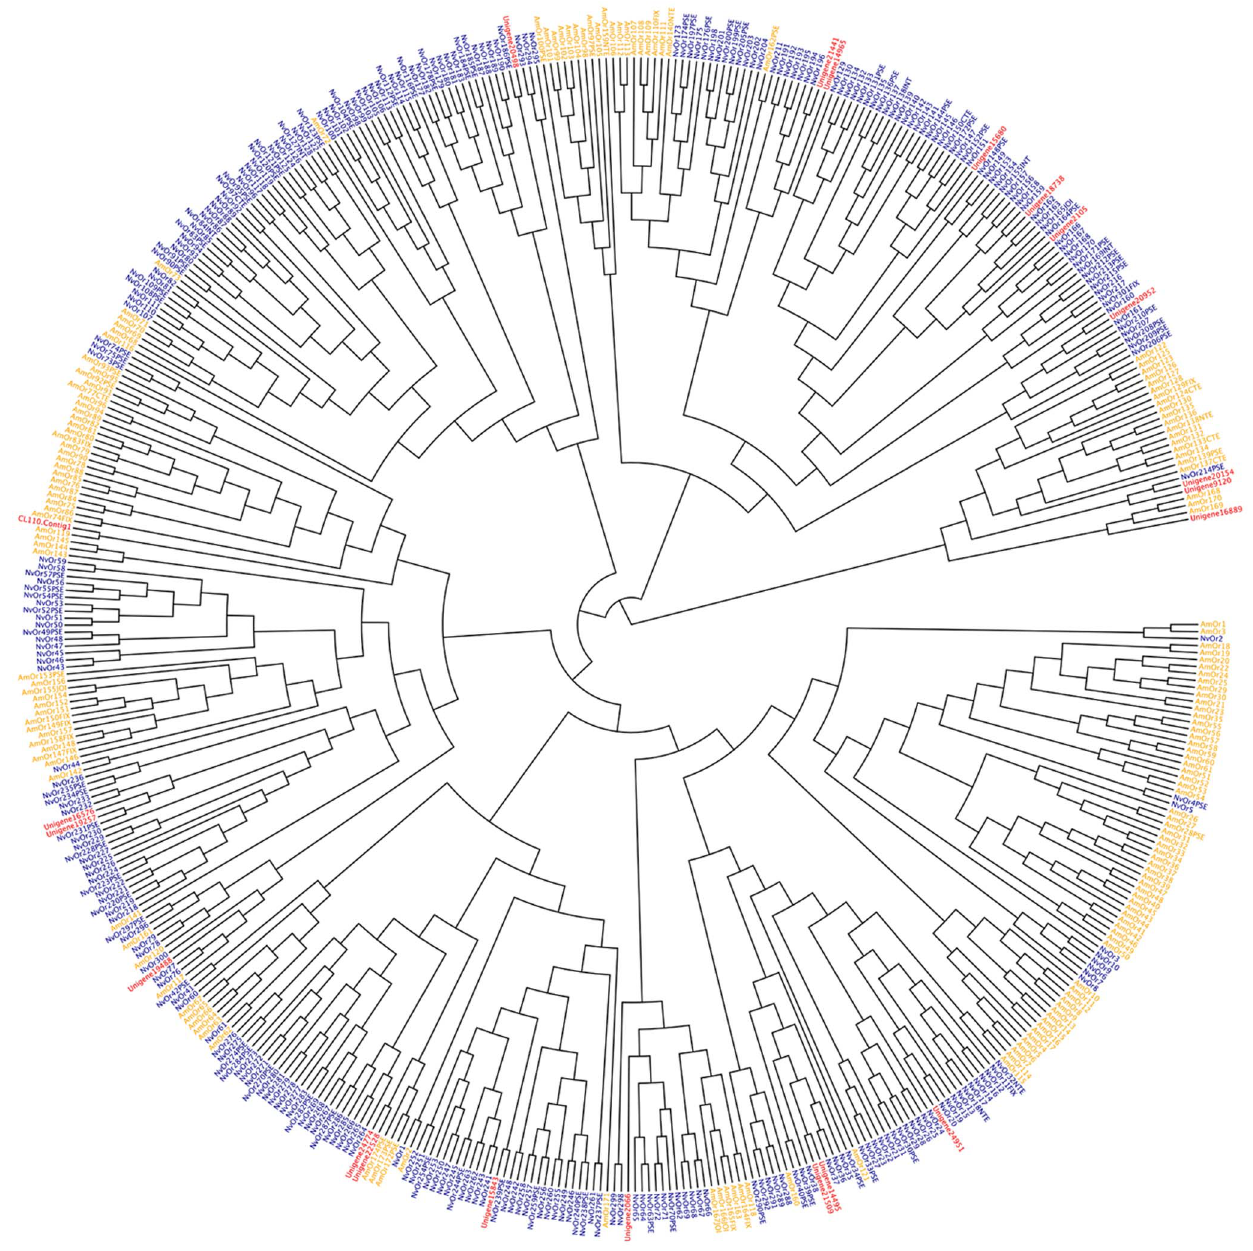
Figure 4. Phylogenetic tree of the odorant receptor (Or) family in S.endius , N.vitripennis and A.mellifera . AmGrs are marked in orange, NvGrs are in blue and PvGrs are